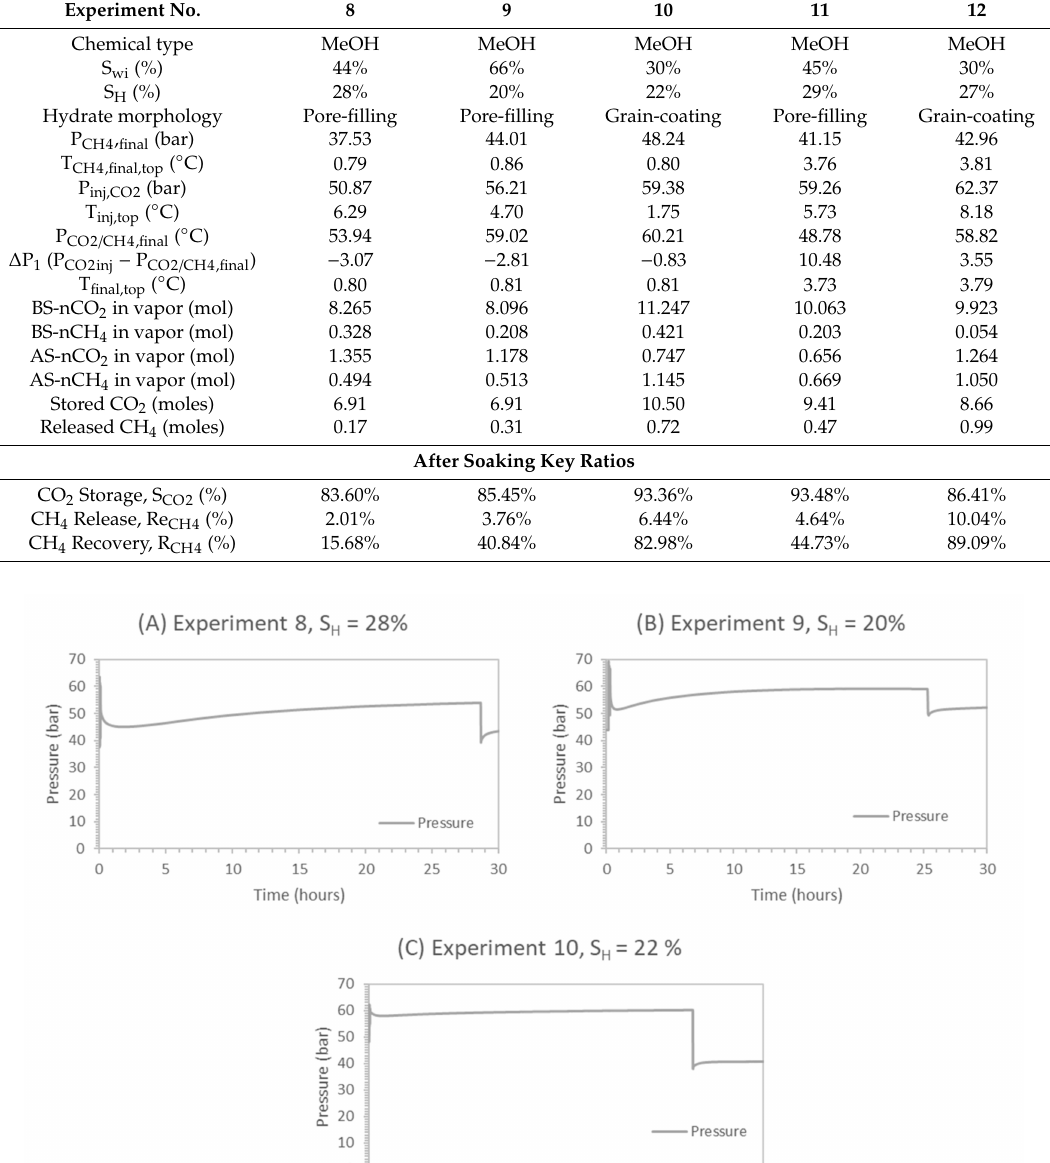
Table 7. Collected experimental data from the CH 4 -CO 2 exchange process with 5 wt% MeOH under various liquid saturations and experimental temperatures. Key ratios are calculated from 24-h soaking period when the replacement process occurred (BS = before swapping, AS = after soaking). Experiment No.